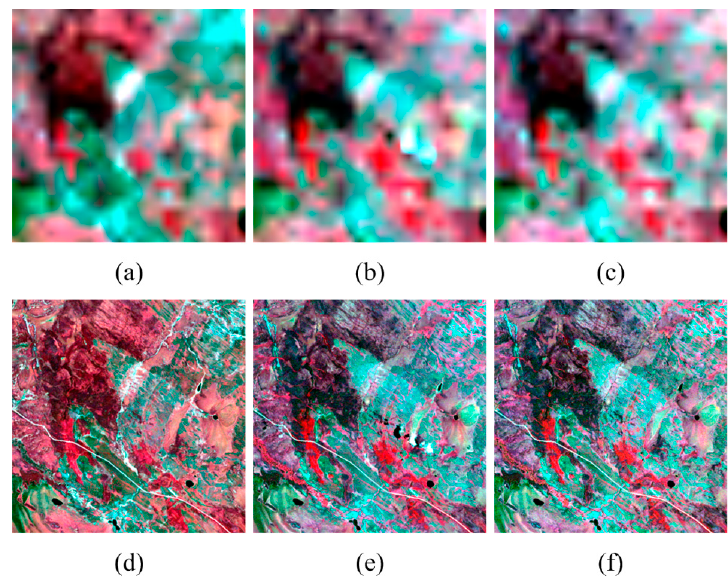
Figure 2. Near-infrared (NIR)–green–blue composites of the simulated-MODIS imagery ( upper row ) and Landsat imagery ( lower row ) taken on ( a , d ) 24 May 2001, ( b , e ) 11 July 2001, and ( c , f ) 12 August 2001, respectively.